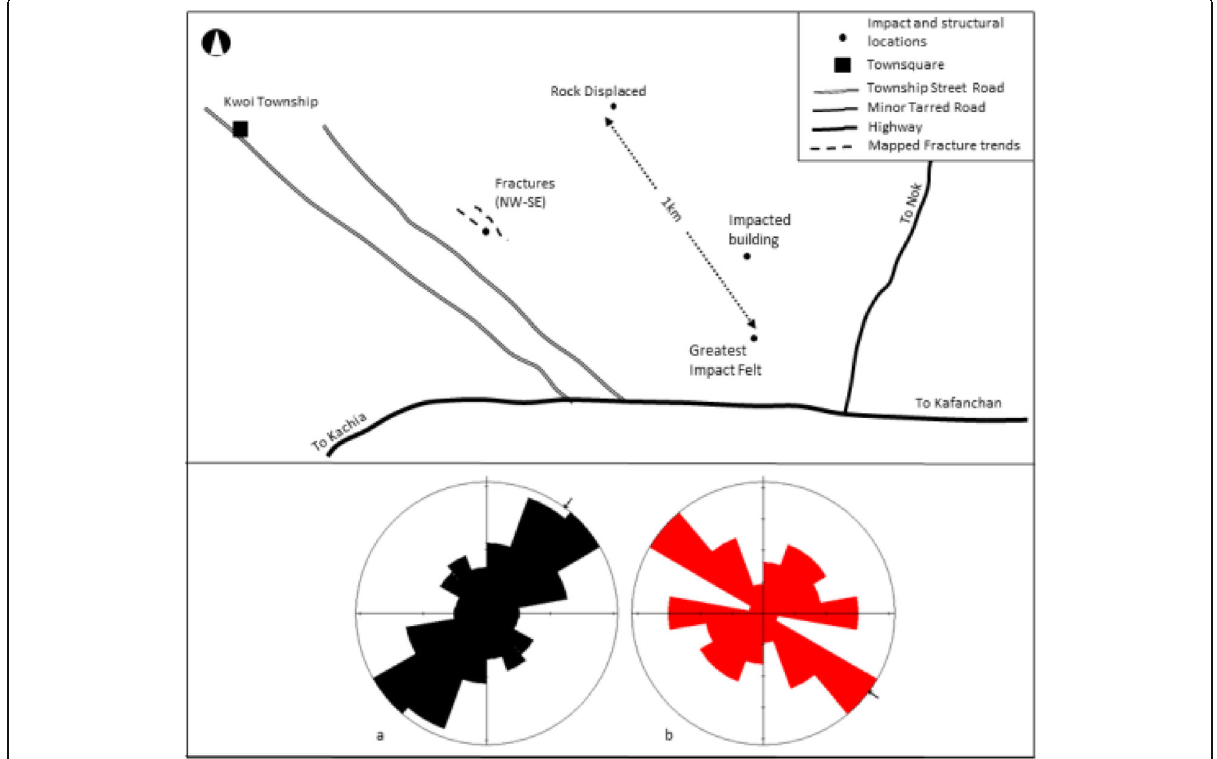
Fig. 11 Map of the Kwoi township area displaying areas of high impact during the tremor and the mapped fractures. Fracture and lineament trends for the area are shown in ( a ) lineaments generated from Spot 5; ( b ) fracture trends from field measurements on granitic